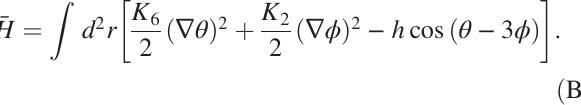
FIG. 9. (a) Illustration of the λ constraint; domain walls of the relative variable σ ¼ 2 π n= 3 , as defined in Eq. (4.4), are situations where the θ and ϕ do not fall in the deep minima of V . (b) The domain of both θ and ϕ is ½ 0 ; 2 π Þ corresponding to the model of Eq. (3.1). This is different from the ϑ and φ variables from Fig. 1 that are defined mod 2 π = 3 and 2 π , respectively. (c) Visualization of a hexatic vortex q θ ¼ 1 with its adjacent domain wall of the relative variable σ ¼ 2 π n= 3 of width ξ . This can also be DW vortex. (d) A composite vortex of viewed as a fractional q ϕ ¼ 1 3 total charge q ϕ ¼ 1 and q θ ¼ 3 , which is clearly seen outside the core. It is formed of three q θ ¼ 1 vortices [blue dots; see panel (c)] behaving as fractional q ϕ ¼ 1 = 3 objects bound by their domain-wall strings. These fractional objects are arranged in this simple geometry where the walls are of length R and the distance ffiffiffi p 3 R between q θ ¼ 1 vortices is